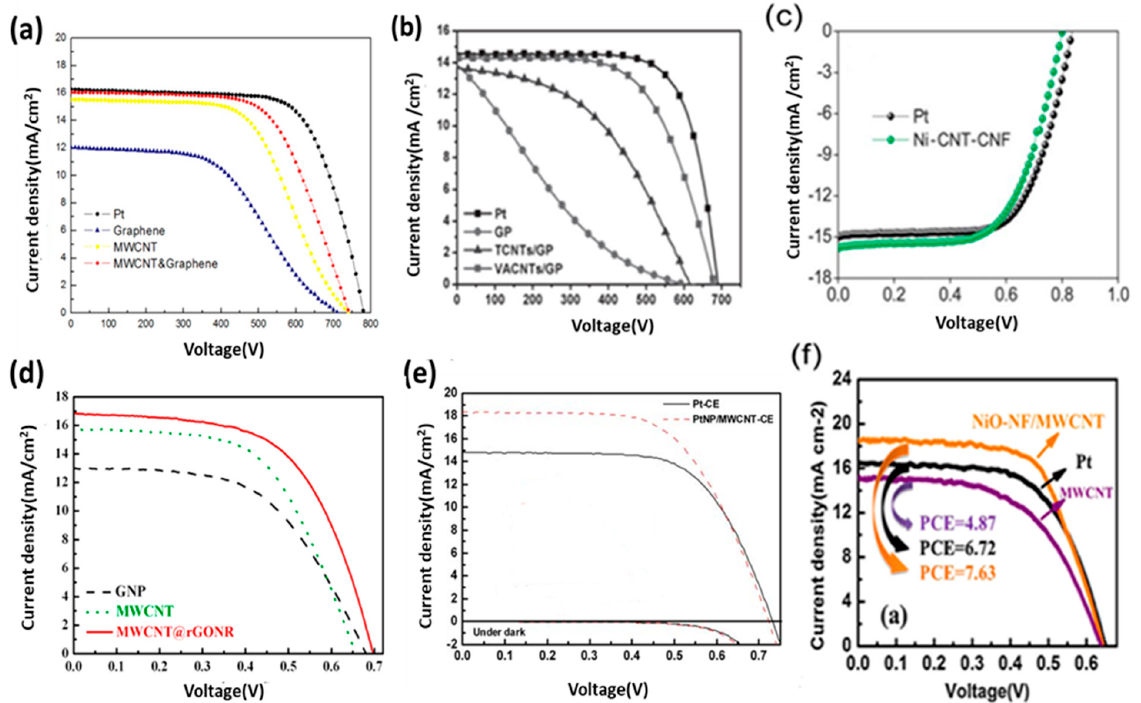
Figure 17. J–V curve of hybrid CNT materials: ( a ) CNTs-Gr. Reprinted with permission from Reference